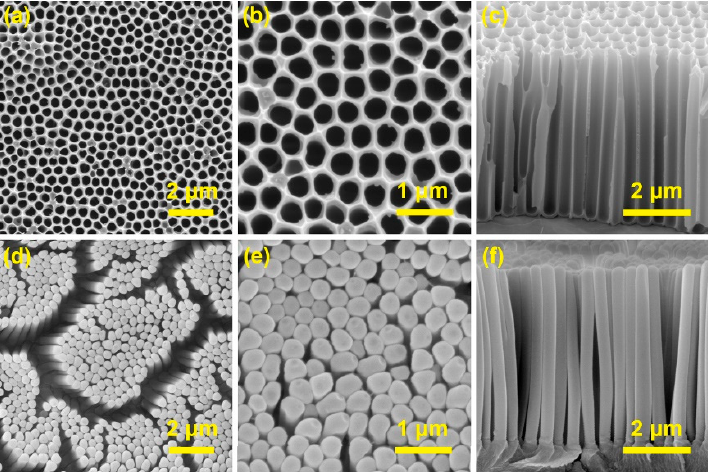
Figure 2. ( a – c ) SEM images of the AAO template. ( d – f ) SEM images of the polymer replica.